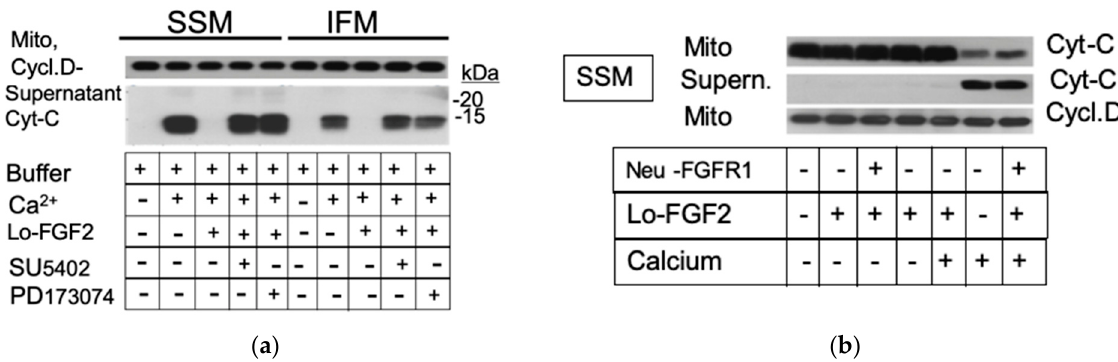
Figure 3. FGFR1 inhibition or neutralization prevents mito-protection by Lo-FGF2 against calcium overload: ( a ) Western blots of mitochondrial particulate fraction (Mito) and Supernatant fraction, probed for cyclophilin D (Cycl.D) or cytochrome c (Cyt-C), as indicated. Electrophoretic migration of markers is shown as -20 and -15 kDa. The Lo-FGF2 protection from calcium-induced cytochrome c release (mPTP) to the supernatant is prevented by both FGFR1 inhibitors SU-5402 and PD-173074 in both SSM and IFM; ( b ) Western blots of mitochondrial (SSM) particulate fraction (Mito) and supernatants, probed for cyclophilin D (Cycl.D) or cytochrome c (Cyt-C), as indicated. The Lo-FGF2 protection from calcium-induced cytochrome c release (mPTP) to the supernatant is prevented by anti-FGFR1 neutralizing antibodies, neu-FGFR1. Cytochrome c in the particulate (Mito) mitochondrial suspension is reduced when supernatant cytochrome c is increased; Cycl.D indicates similar protein amounts between Mito samples.